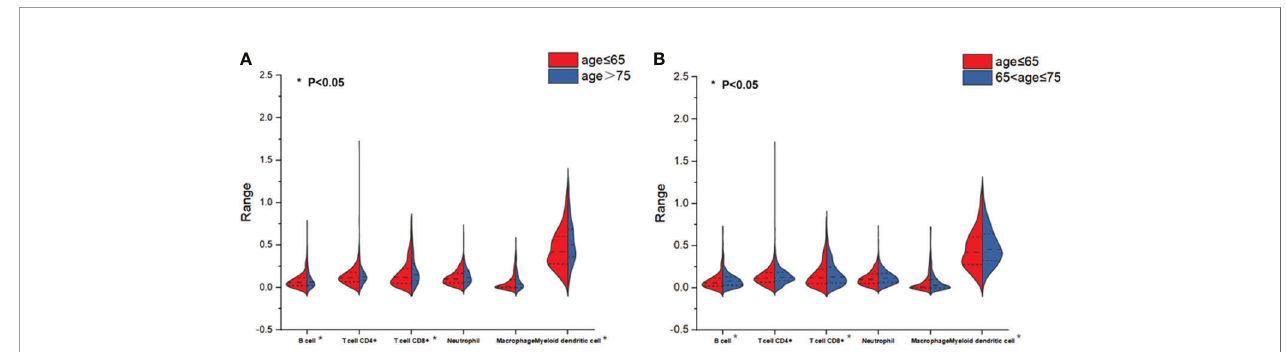
FIGURE 1 | Split violin plots estimating the distributions and levels of immune cell in fi ltration. (A) In fi ltration differences of 6 immune cells between patients aged ≥ 75 (old patients) versus patients aged <65 (young patients). Red indicates the young patient subgroup and blue indicates the old patient subgroup. (B) In fi ltration differences of six immune cells between patients aged 65 to <75 (middle-aged patients) versus patients aged <65 (young patients). Red indicates the young patient subgroup and blue indicates the middle-aged patient